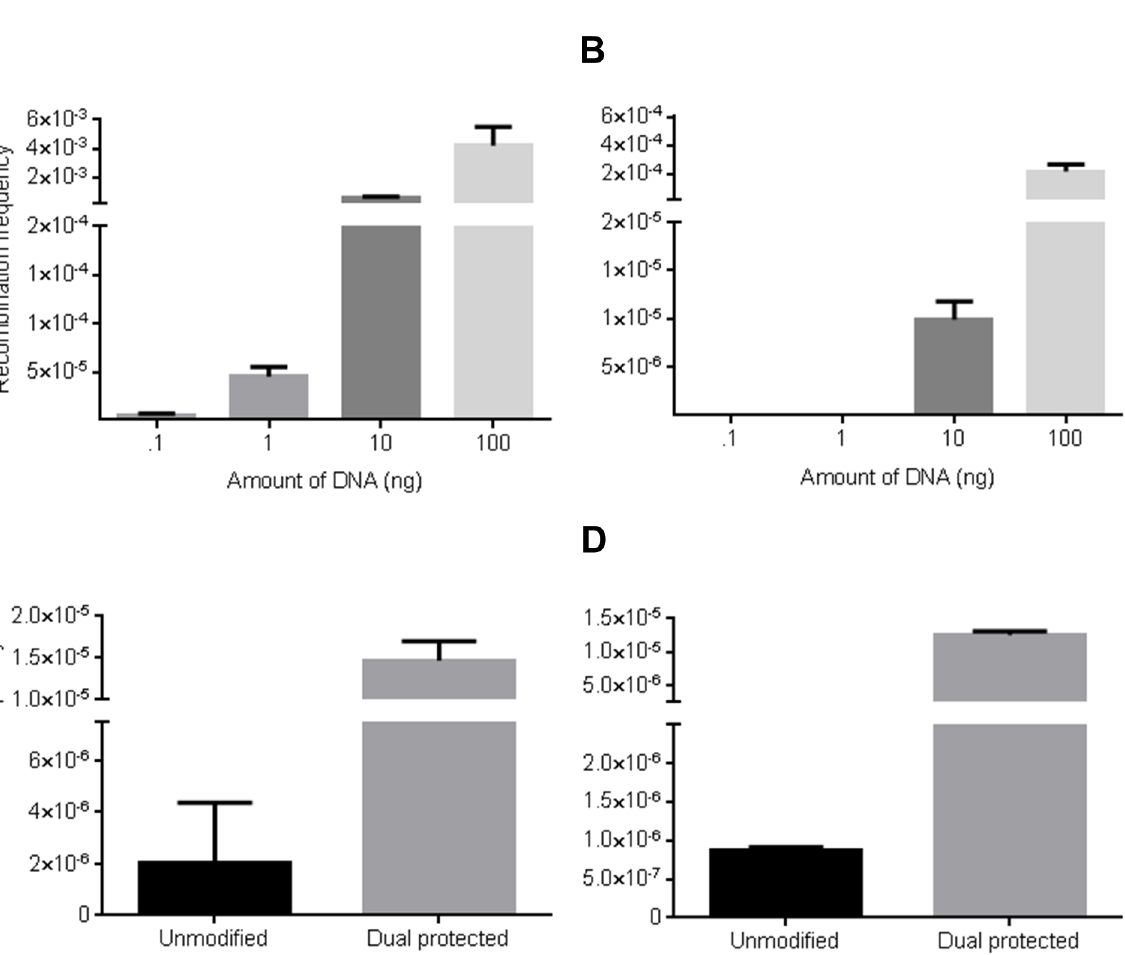
Fig 3. Multiplex recombination is limited by availability of DNA template. (A) Insertion assay. A Gentamicin lagging strand protected cassette was inserted at a site of the P2rx1 gene. (B) Multiplex insertion. Two different Gentamicin and Zeocin lagging strand protected cassettes were inserted at two different sites of the P2rx1 gene. Recombination assays were performed with different amounts of each DNA cassette in the electroporation. Values represent averages; error bars indicate standard error of mean ( n = 4). (C) Multiplex insertion PTO assay. Three different Zeocin, Gentamicin and Blasticidin resistance cassettes were PTO protected or unmodified and inserted at three different sites of the P2rx1 gene ( n = 3). (D) SPI PTO assay. SPI was performed using a p15A dhfrII subcloning plasmid and the Zeocin and Gentamicin cassettes used in (A) ( n = 3).